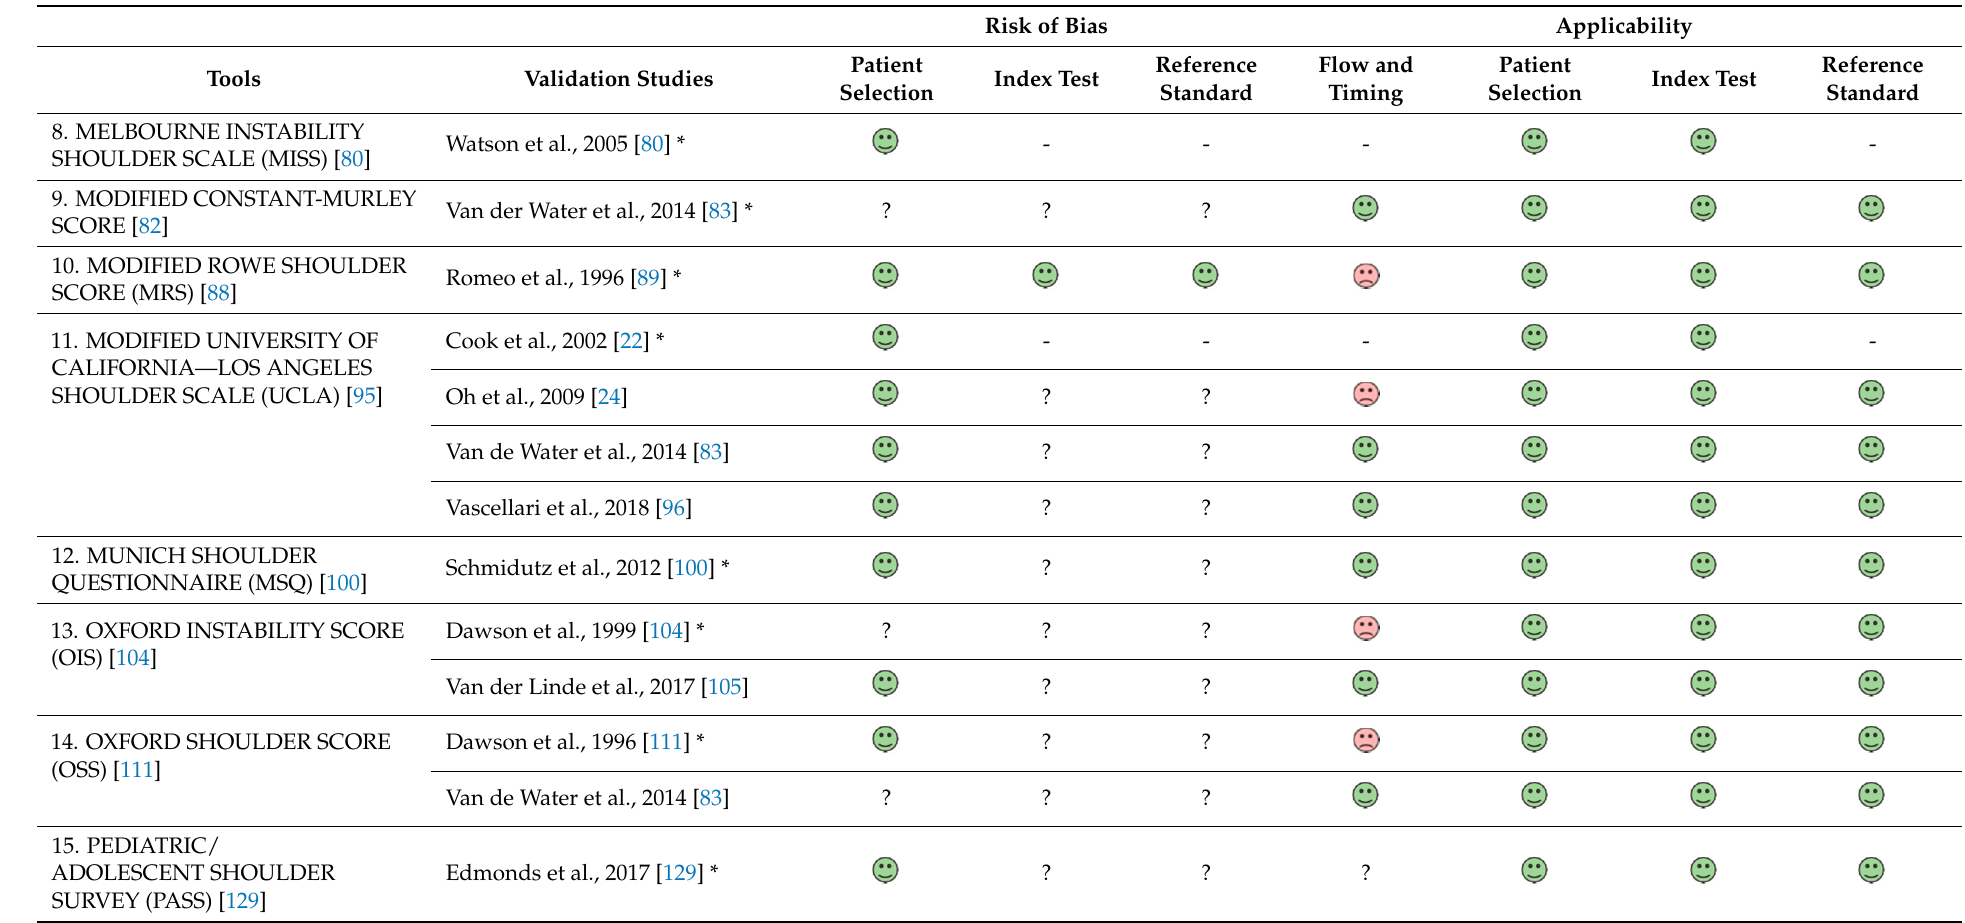
Table 3. Assessment of the methodological quality with QUADAS ‐ 2.